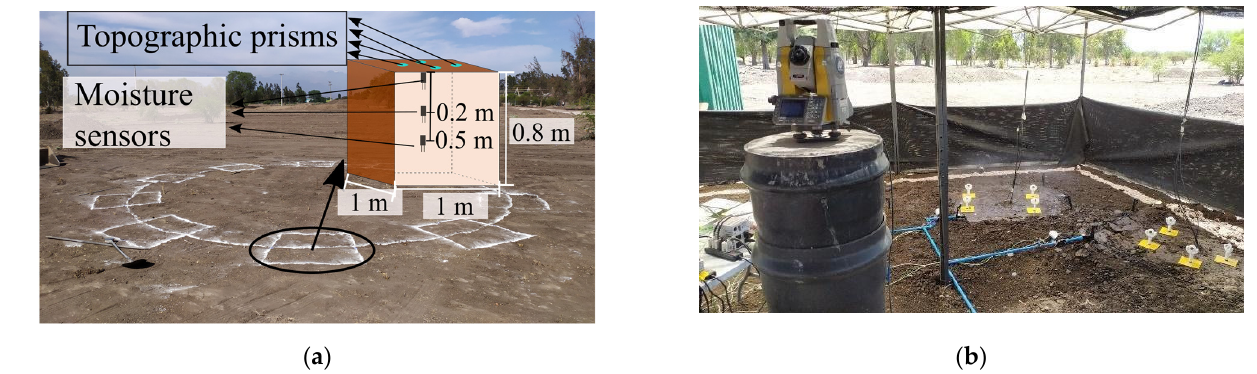
Figure 8. Field test setup: ( a ) array of soil parcels; ( b ) instrumentation of soil array.